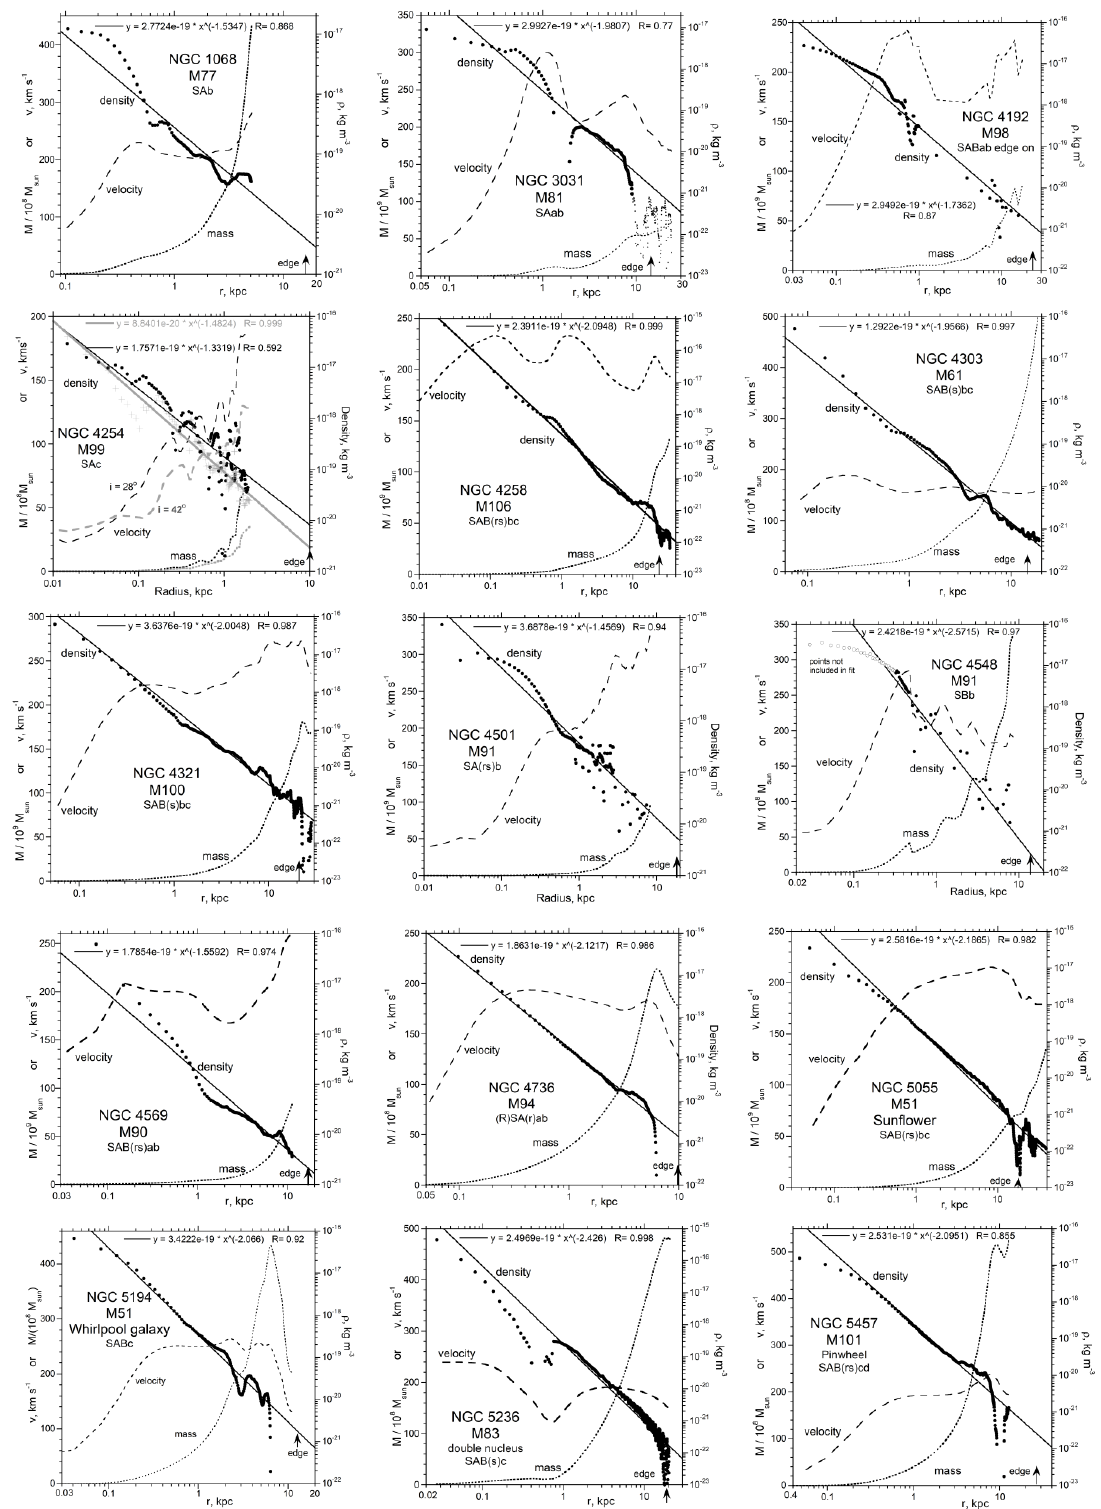
Figure A5. Three small spirals: RC data from Bottema and Pestaña [64].